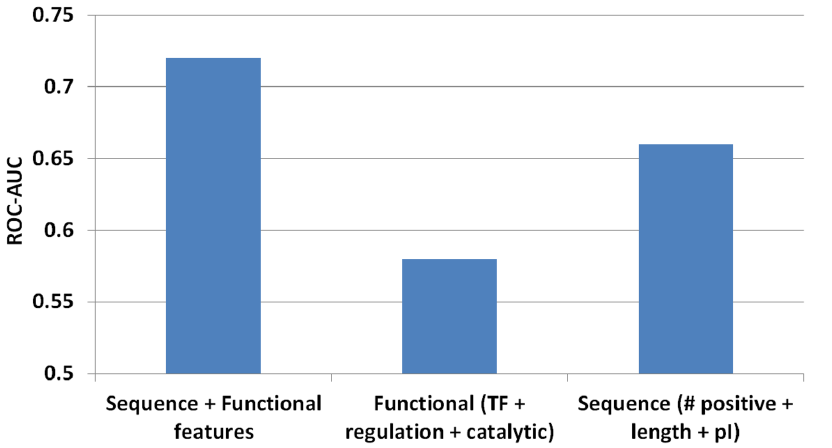
Figure 5. Independence of sequence and functional properties in predicting toxicity. Prediction accuracy (ROC-AUC) of overexpression toxicity from sequence (positively charged residue count, pI, and length) and functional features (transcription factor, regulation and catalytic function information). Combining sequence and functional features increases the predictive power indicating at least their partial independence. TF=transcription factors, pI=Isoelectric